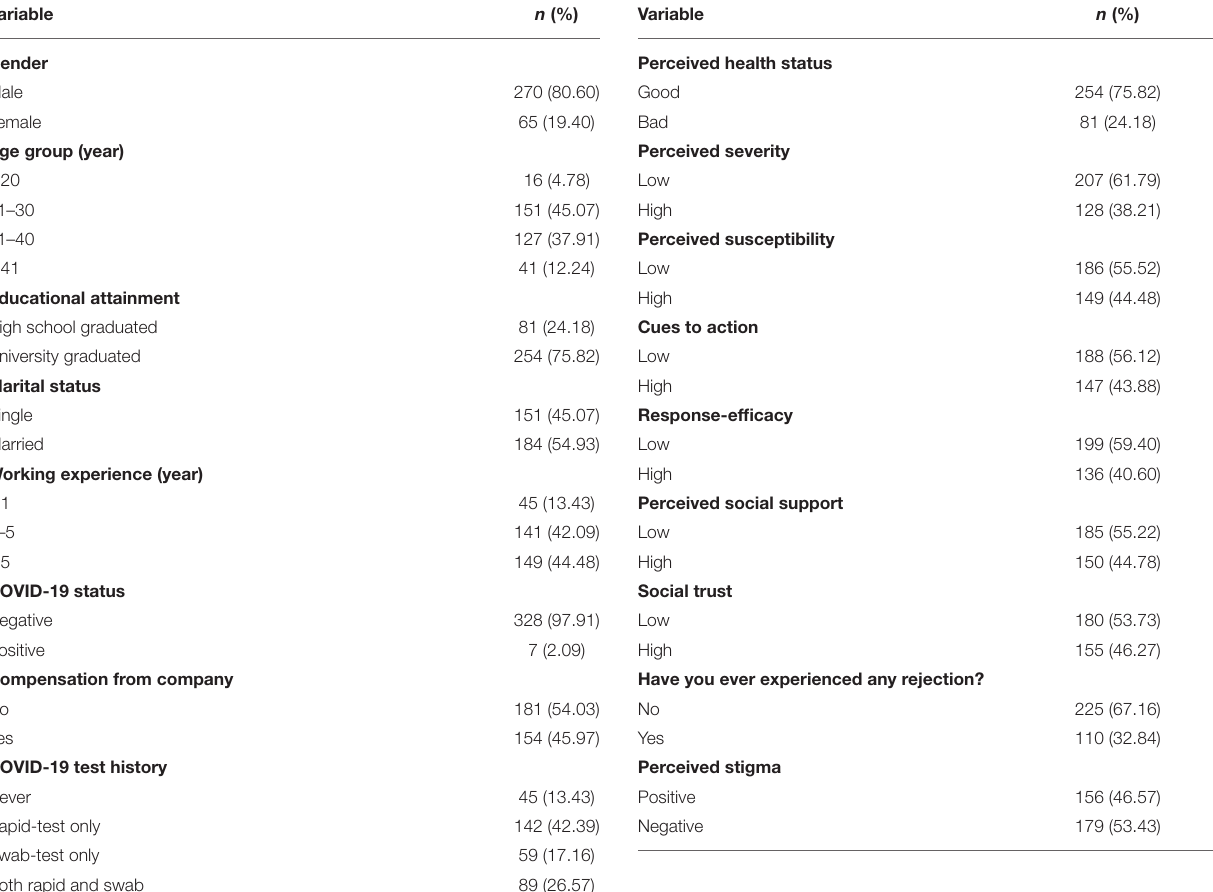
TABLE 2 | The HBM constructs and psychosocial factors of Indonesian migrant workers ( n = 335).